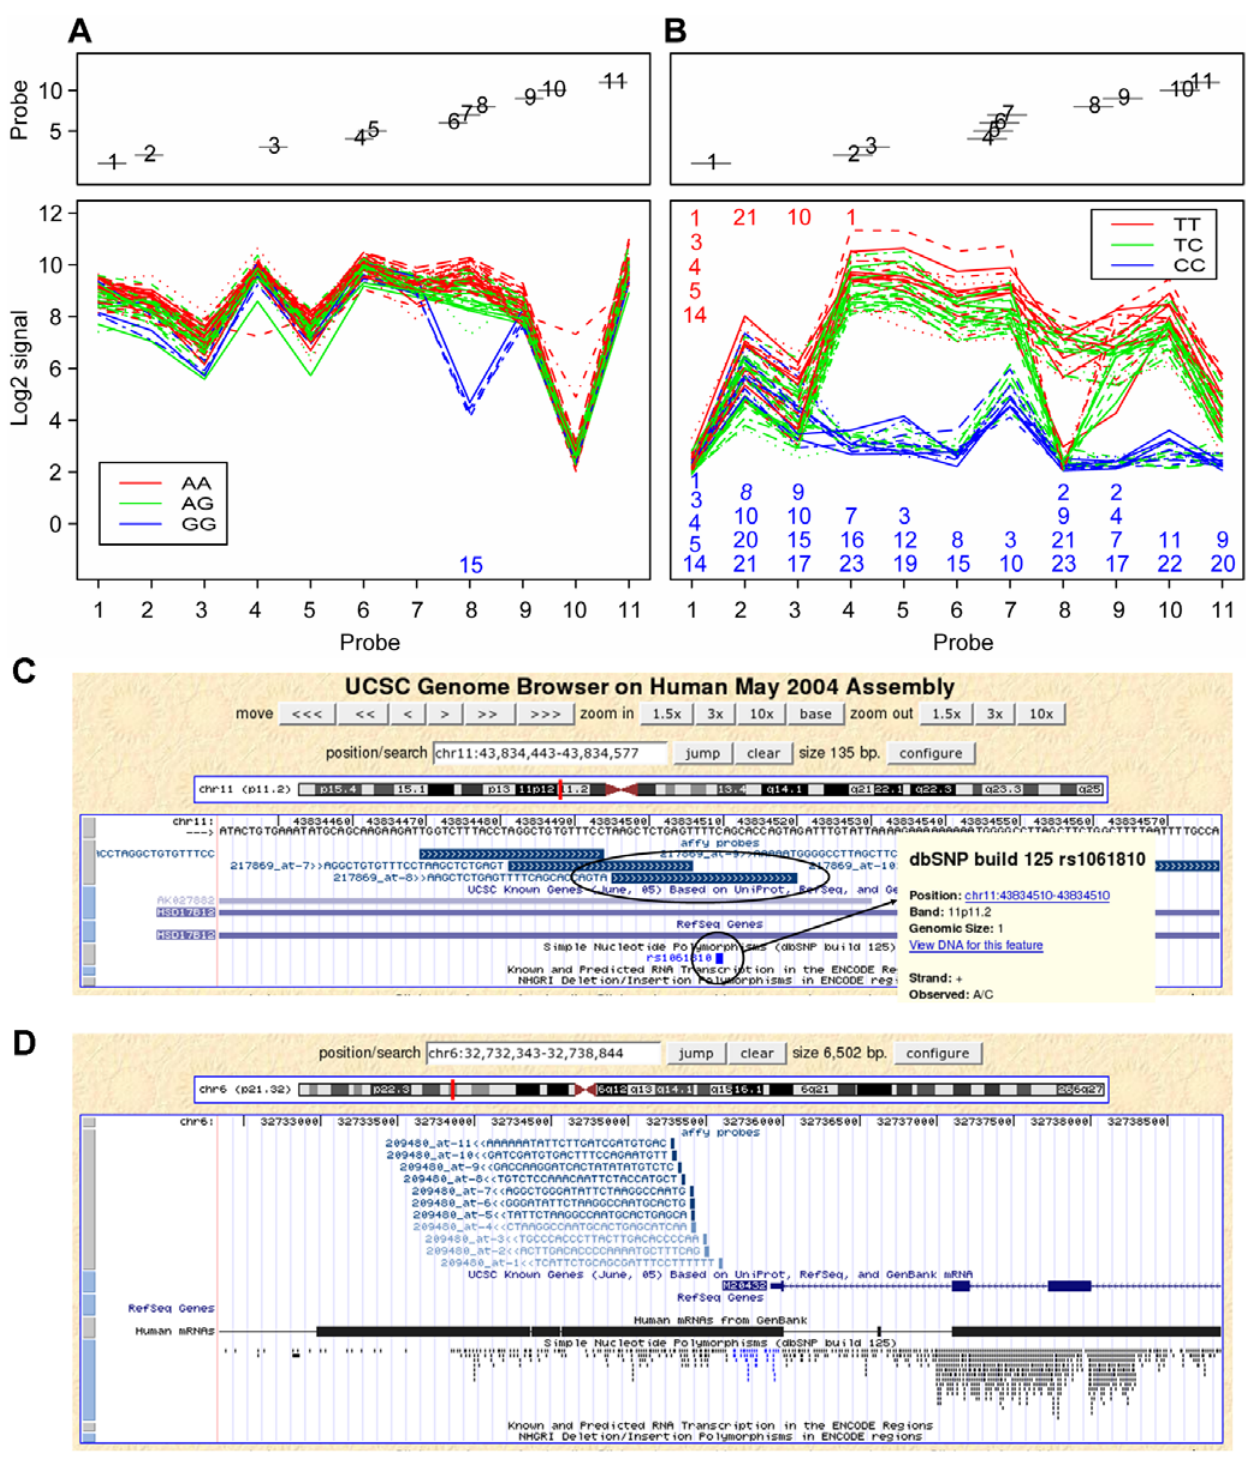
Figure 1. Identification of false ciseQTLs reported in a human association analysis. (A) Relative probe positions on the mRNA sequence (top) and hybridization signals (bottom) for gene HSD17B12 for which a cis eQTL is reported [9]. Each line represents one individual and is colored according to the allele that the individual carries for the associating SNP marker rs4755741. This marker is located in an intron of the HSD17B12 gene and it is strongly linked with SNP rs1061810 located in probe 8. By discarding the data for probe 8, the significance for a cis eQTL disappears. (B) Similar plot for gene HLA-DQB1 for which a cis eQTL is reported [9]. Lines are colored according to the allele the individual carries for the associated SNP marker rs6928482. One red-line and one blue-line individual have been sequenced for the probe region; the numbers in red and blue indicate the positions of SNPs within the 25-mer probe regions. The number in italic indicates a single nucleotide insertion in probe 2. We observed 23 SNPs (15 new ones) between these mRNA sequences and the 11 probes.